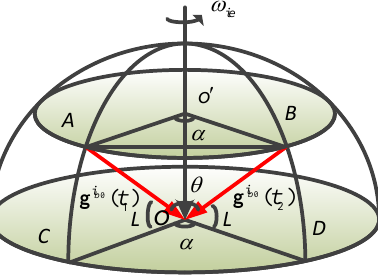
Figure 1. Geometric relationship diagram for the latitude estimation.